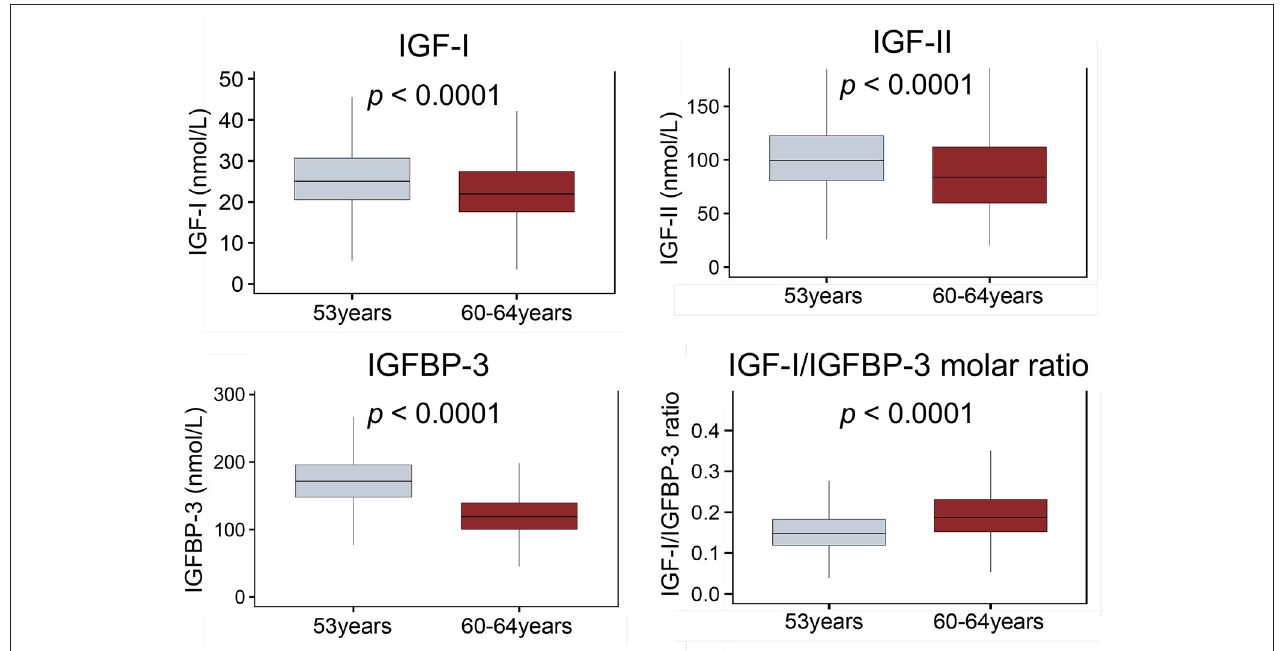
FIGURE 2 | Boxplots comparing circulating levels of IGF-I, IGF-II, IGFBP-3 and IGF-I/IGFBP-3 molar ratio at 53 and 60–64 years. Whiskers indicate variability outside the third and first quartiles [75th and 25th percentiles] represented as hinges around the median [bold midline]. p -Values derived from Mann-Whitney tests. ECG, electrocardiography; IGF-I, insulin-like growth factor 1; IGF-BP3, insulin-like growth factor binding protein